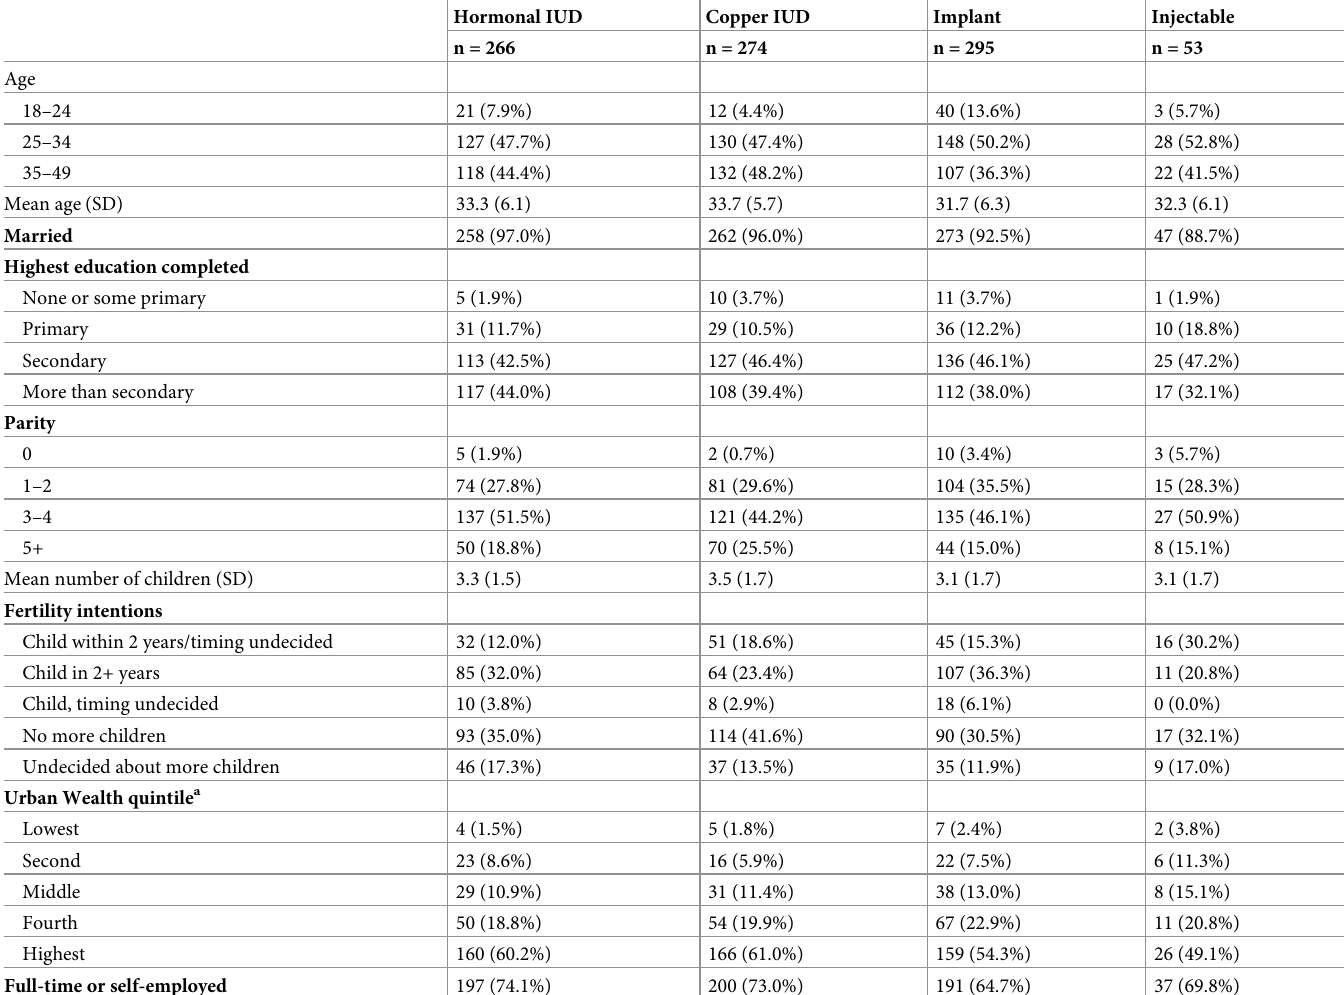
Table 1. Participant